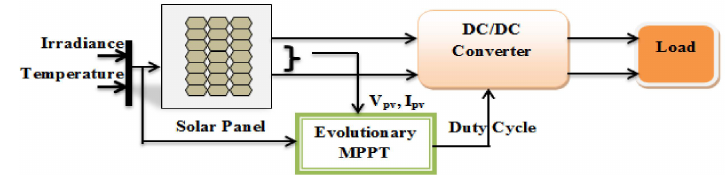
Figure 1. Diagram of PV connected to a load.